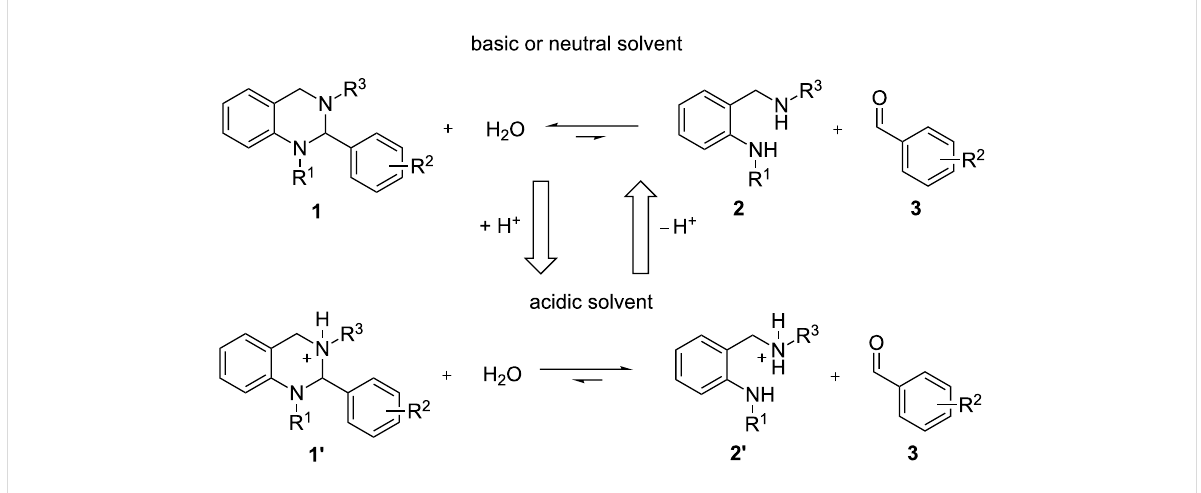
Figure 6: Reaction equilibrium between tetrahydroquinazoline 1 , the corresponding diamine 2 and aldehyde 3 in basic or neutral media as well as for the protonated tetrahydroquinazoline 1’ and the corresponding diamine 2’ and aldehyde 3 in acidic media.